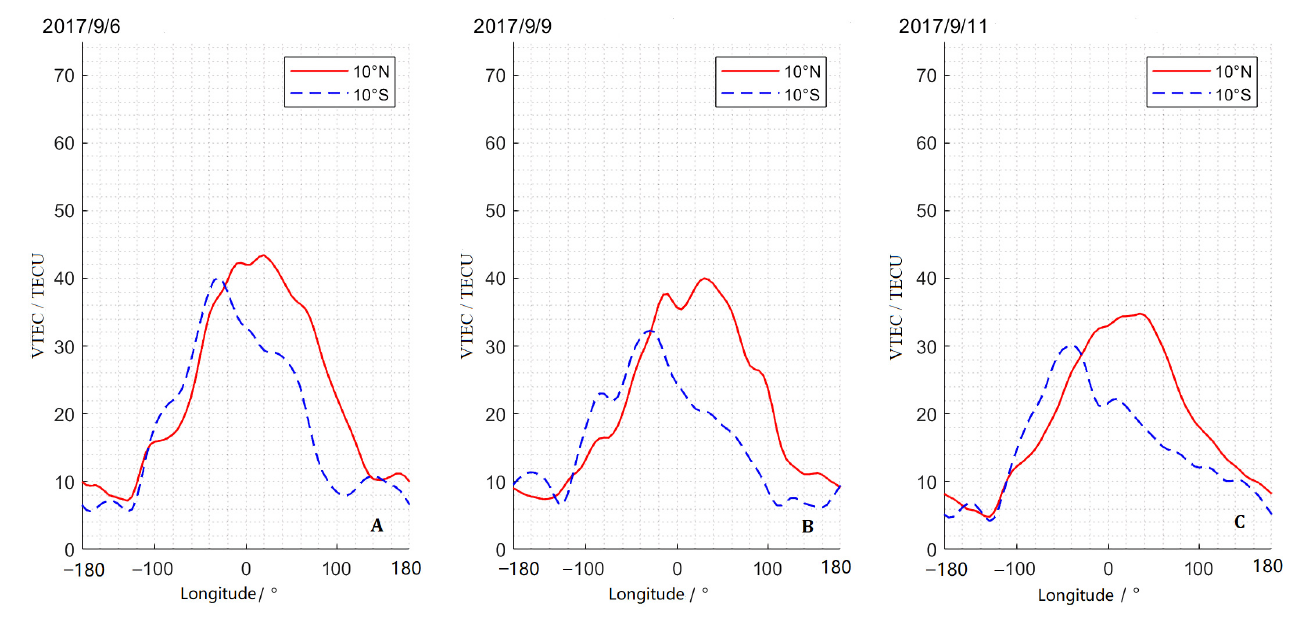
Figure 8. Fluctuation characteristics of VTEC on 10° N/S latitudes at UTC 14:00. Panels ( A – C ) represent the experimental results of the three stages before, during, and after the geomagnetic storm, respectively. The blue dotted line and the red solid line represent the southern and northern hemisphere VTEC, respectively, unit: TECU.